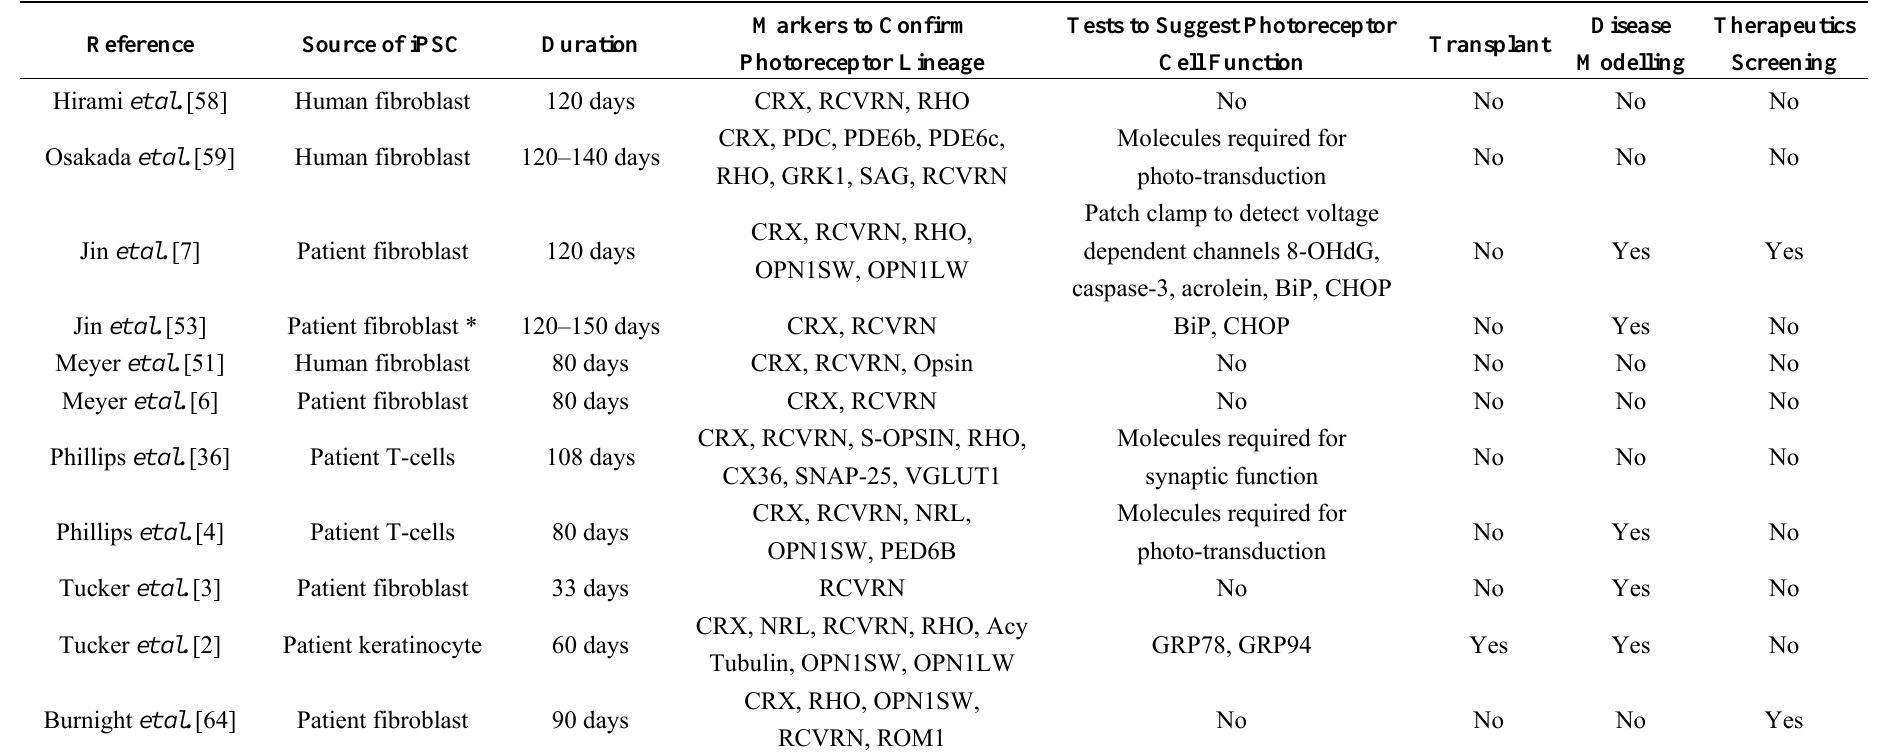
Table 2. Derivation of retinal photoreceptor (precursor) cells from human induced pluripotent stem